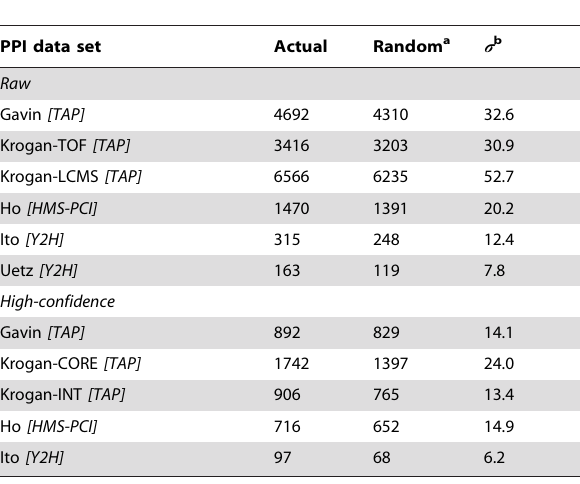
Table 5. Enrichment of interactions between essential proteins in raw and high-confidence yeast PPI data